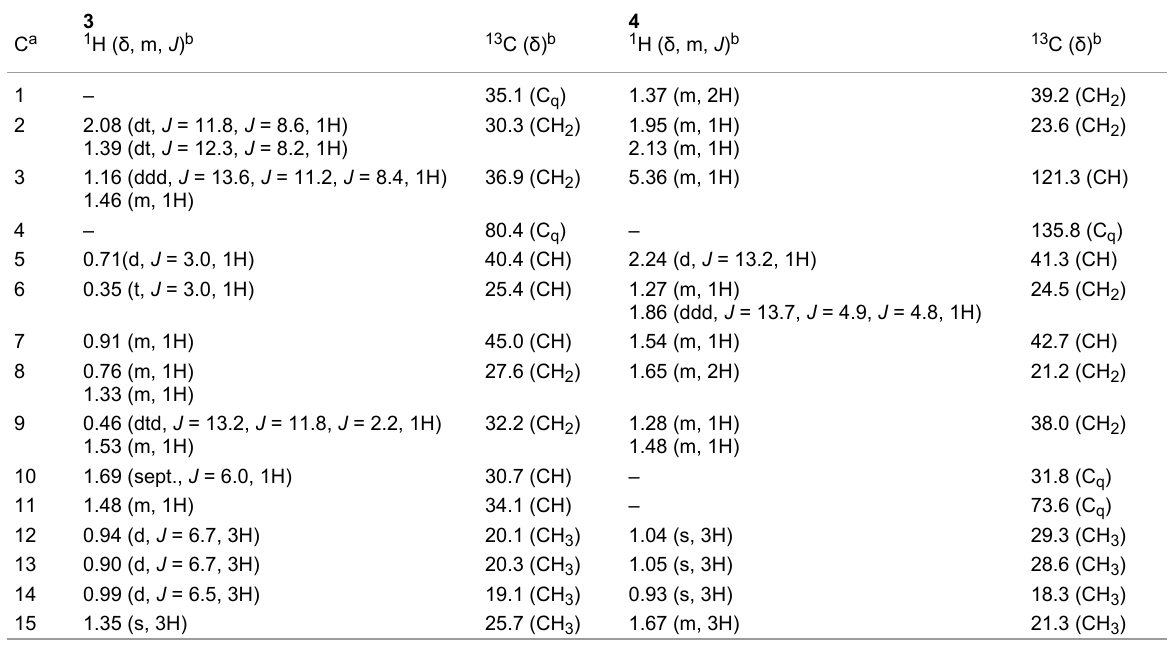
a Carbon numbering as in Figure 1. b Chemical shifts δ in ppm; multiplicities: m = multiplet, s = singlet, d = doublet, sept = septet, br = broad; coupling constants J in